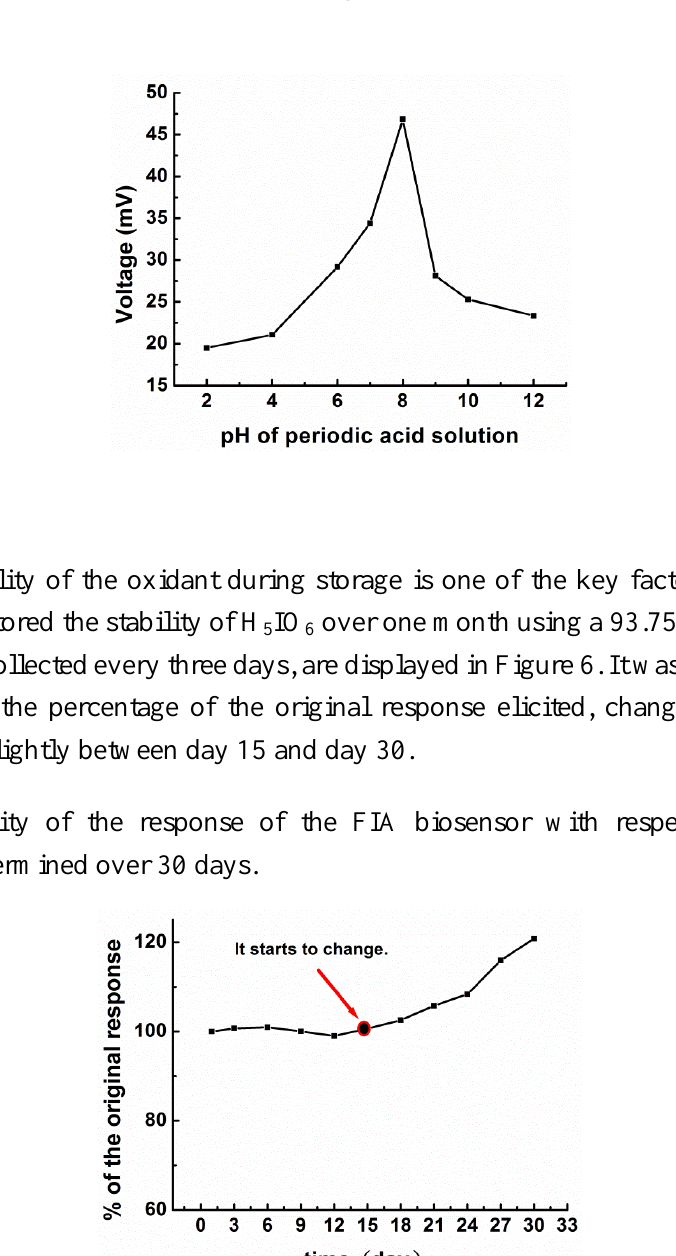
IO on the response of the FIA biosensor. A 350 μL sample of a 5 6